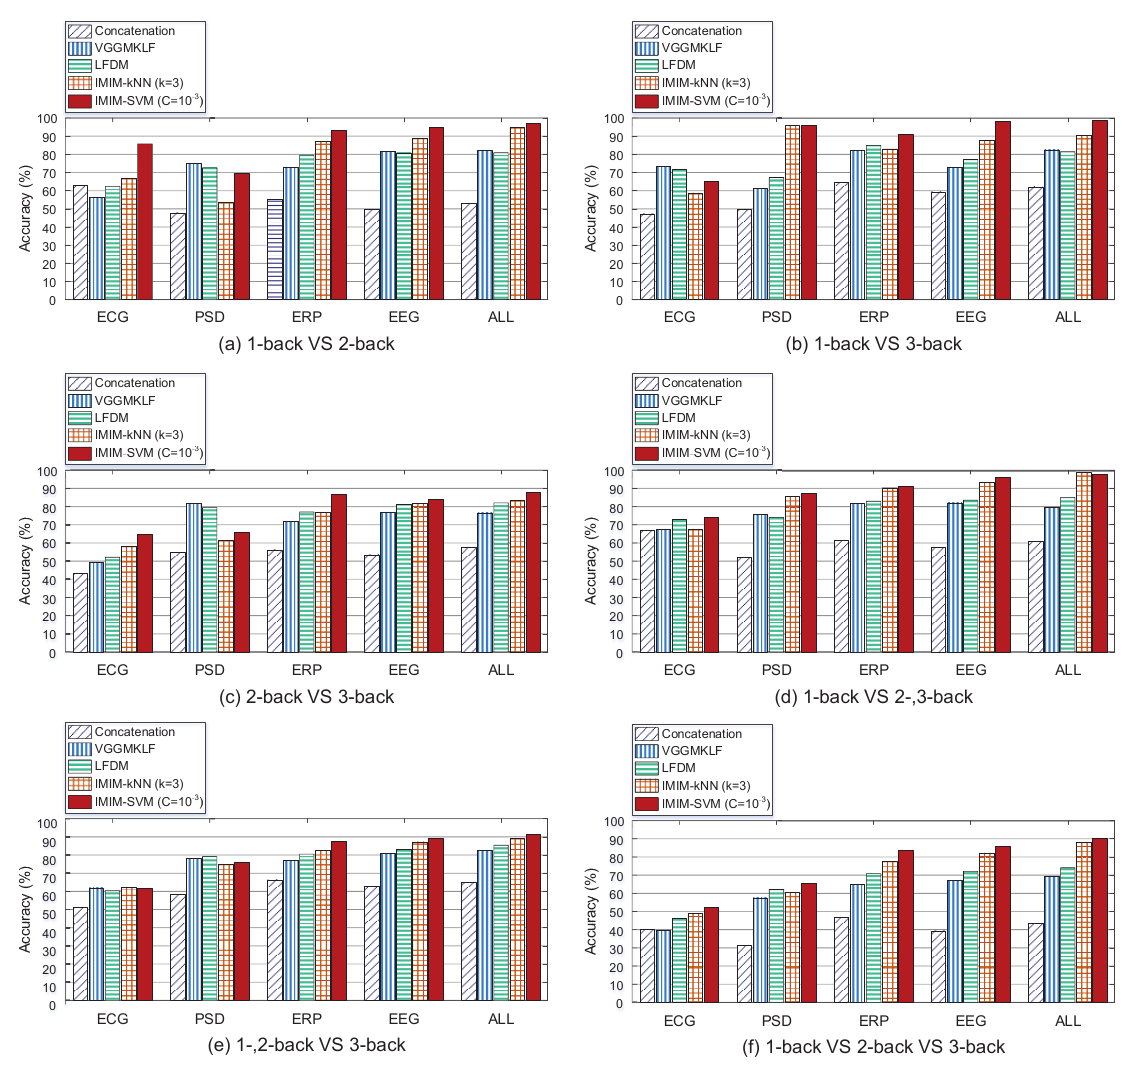
Figure 8. Classification accuracy based on Concatenation method, VGGMKL, LFDM and IMIM-F for feature level fusion. Different single feature vectors and fused feature vectors are all used for mental workload estimation. 6 pairs of mental workload conditions (1-back VS 2-back, 1-back VS 3-back, 2-back VS 3-back, 1 and 2-back VS 3-back, 1-back VS 2 and 3-back, 1-back VS 2-back VS 3-back) are used to compare the performance of the